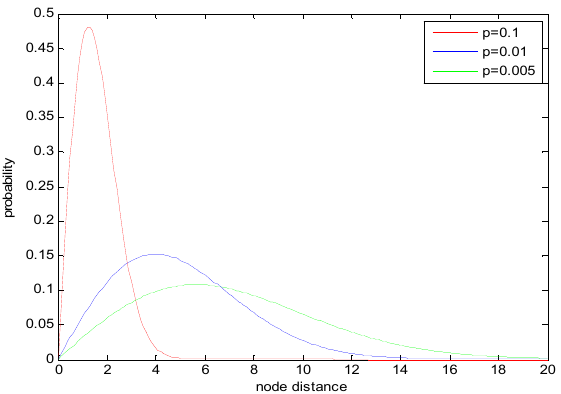
Figure 21. The probability density function of (17).